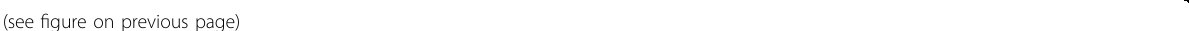
Fig. 2 Macrophage depletion by clodronate liposomes downregulated lymphangiogenesis in UUO mice. A Schematic showing macrophage depletion by clodronate liposomes: 200 µl of clodronate liposomes (Lipo-Clod) or control liposomes (liposomes containing PBS, Lipo-PBS) were injected by intraperitoneal injection 1 day before the operation (UUO), and then 100 µl of clodronate liposomes or PBS liposomes were injected every other day until the mice were sacri fi ced. B Representative western blot showing renal fi brosis (Collagen1, PDGFR- β , and α -SMA) and lymphangiogenesis (Prox-1, LYVE-1, and VEGF-C) in the different groups. Relative mRNA expression of α -SMA ( C ), collagen 1 ( D ), PDGFR- β ( E ), VEGF-C ( F ), Prox-1 ( G ), and LYVE-1 ( H ) in all groups were measured by real-time PCR; * p < 0.05, ** p < 0.01 versus the UUO + Lipo-PBS group. I Representative images showing Masson staining (100×) and immunohistochemical staining (400×) of renal fi brosis ( α -SMA), macrophage in fi ltration (F4/80), and lymphangiogenesis (LYVE-1 and VEGF-C). Norm indicates normal control mice without any treatment, Sham indicates sham-operated mice vs UUO mice, UUO indicates unilateral ureteral obstruction, PBS indicates intraperitoneal injection of PBS, Lipo-PBS indicates intraperitoneal injection of PBS liposomes as a control, and Lipo-Clod indicates intraperitoneal injection of clodronate liposomes. N =